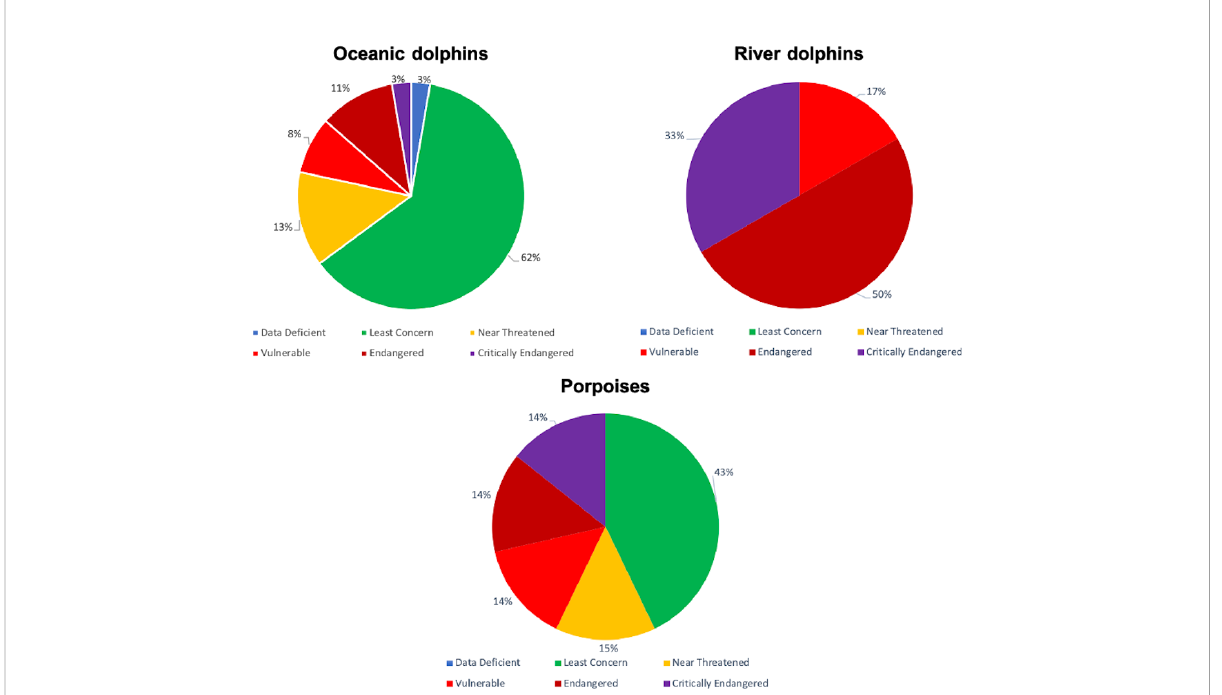
FIGURE 1 IUCN Red List status of oceanic dolphins (Delphinidae: n = 37 species), river dolphins (Platanistidae, Iniidae, Lipotidae, Pontoporiidae, n = 6) and porpoises (Phocoenidae, n =